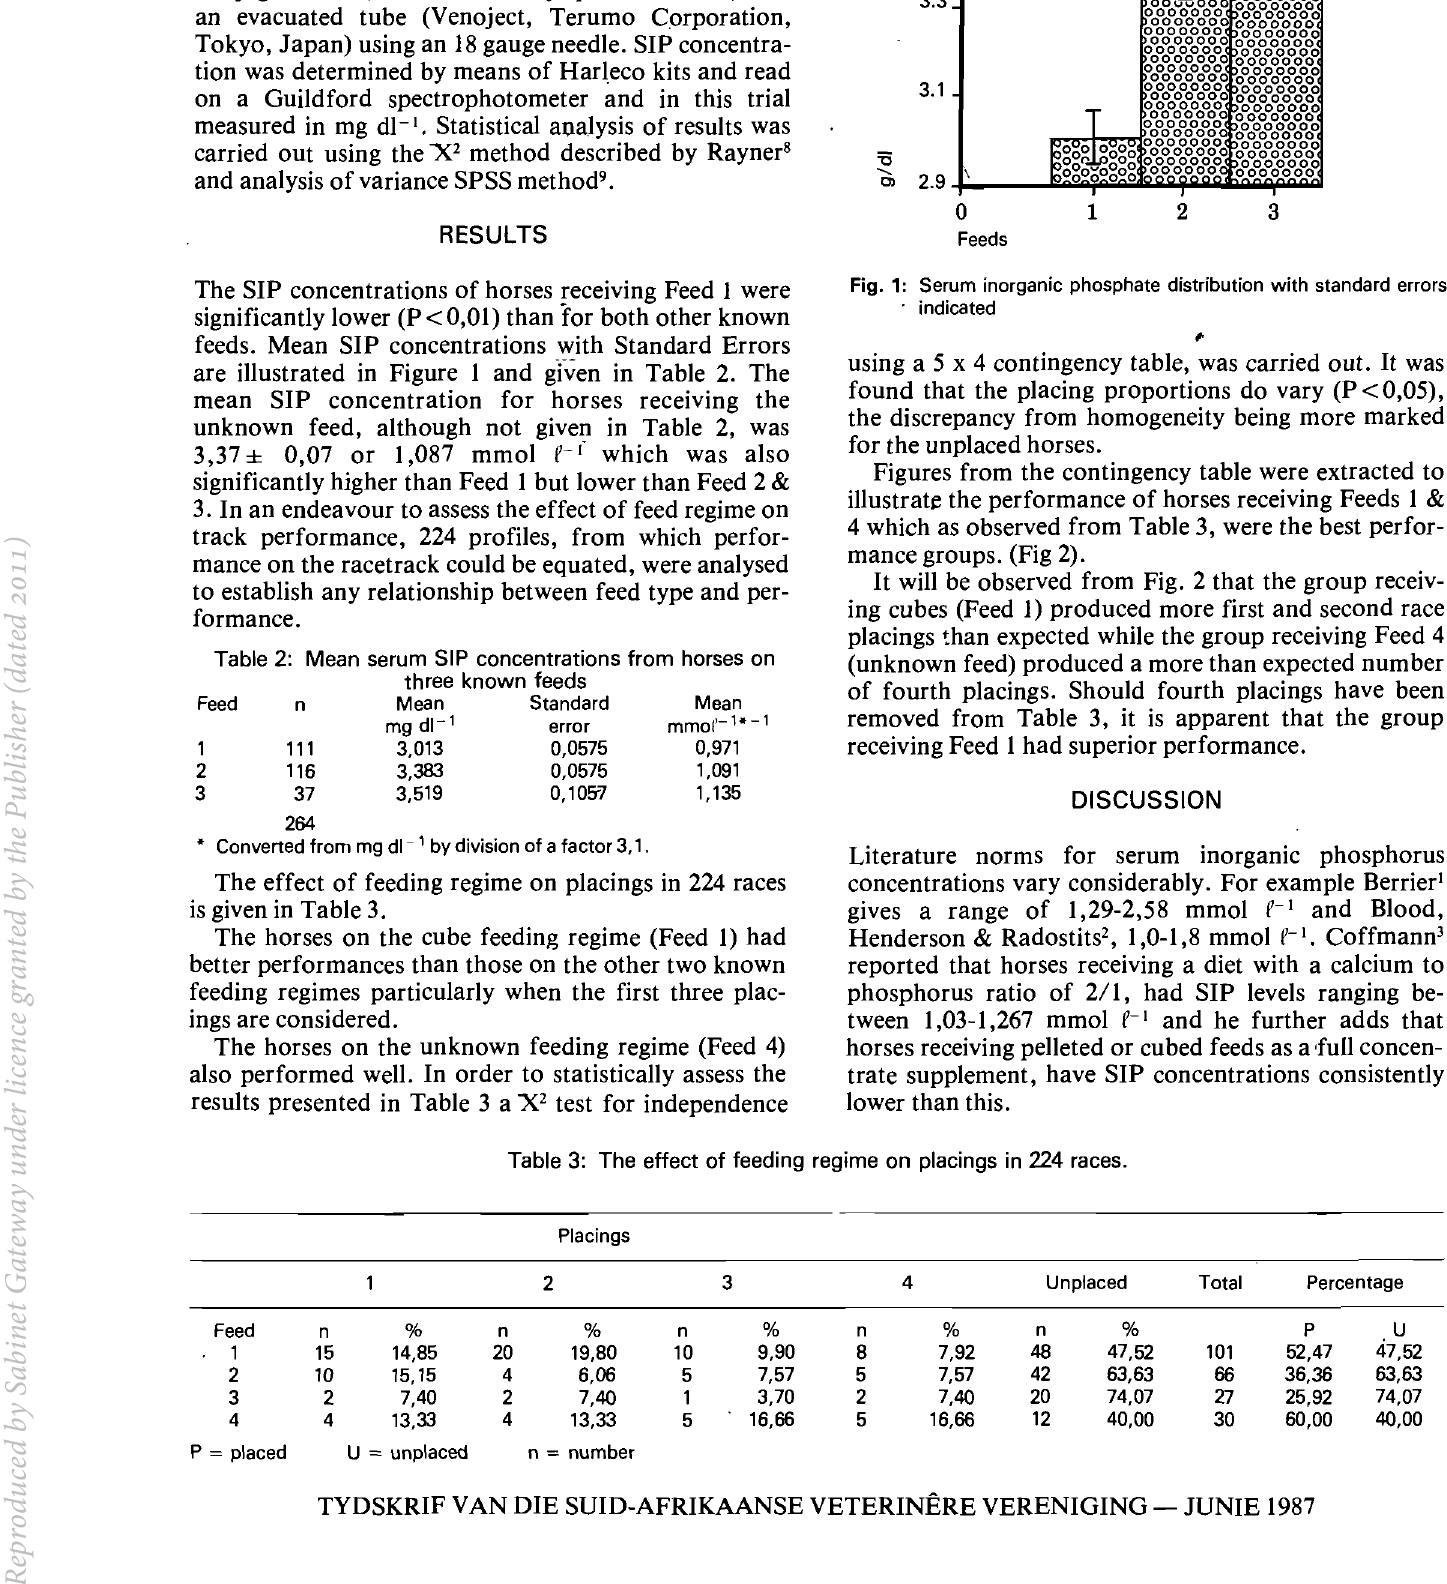
Table 1: Variation of cube supplement/hay ratio fed at different training stages